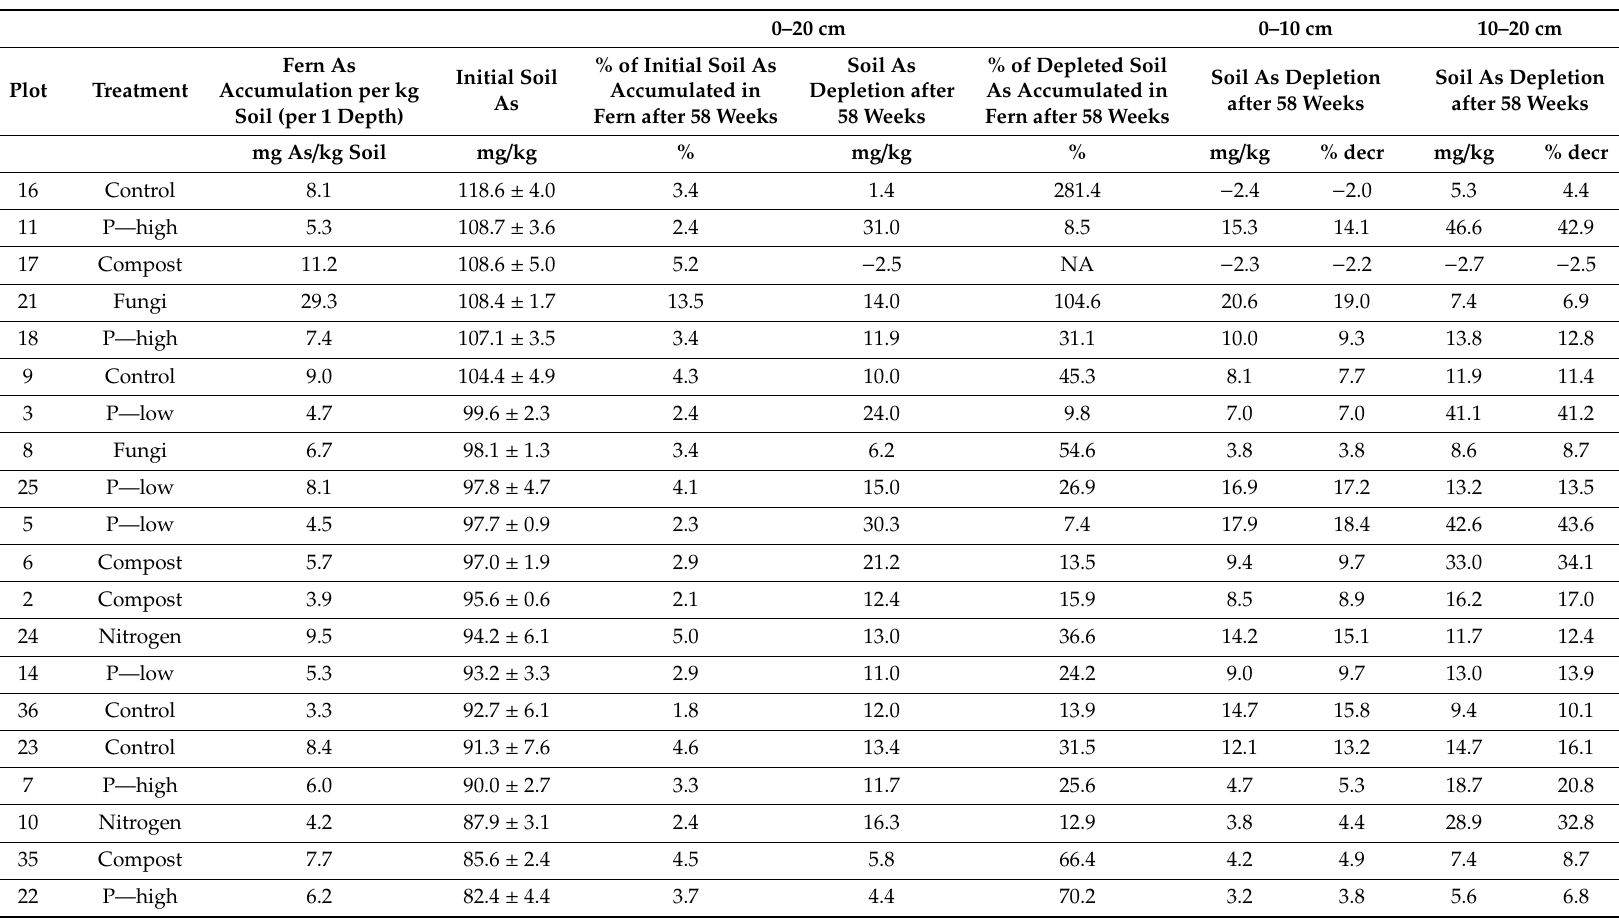
Table 2. Soil–plant mass balance comparing soil arsenic depletion to fern arsenic accumulation after 58 weeks of phytoextraction. Plots are listed in order of decreasing initial soil arsenic. Mass balance compares mean fern arsenic accumulation ( n = 4) per kg soil (per 1 depth) / 2 to mean soil arsenic depletion ( n = 3) across 0–20 cm, or mean fern arsenic accumulation ( n = 4) per kg soil (per 1 depth) to mean soil arsenic depletion ( n = 3) in either 0–10 cm or 10–20 cm depth. Initial soil arsenic values are the mean ± standard error of the mean ( n =